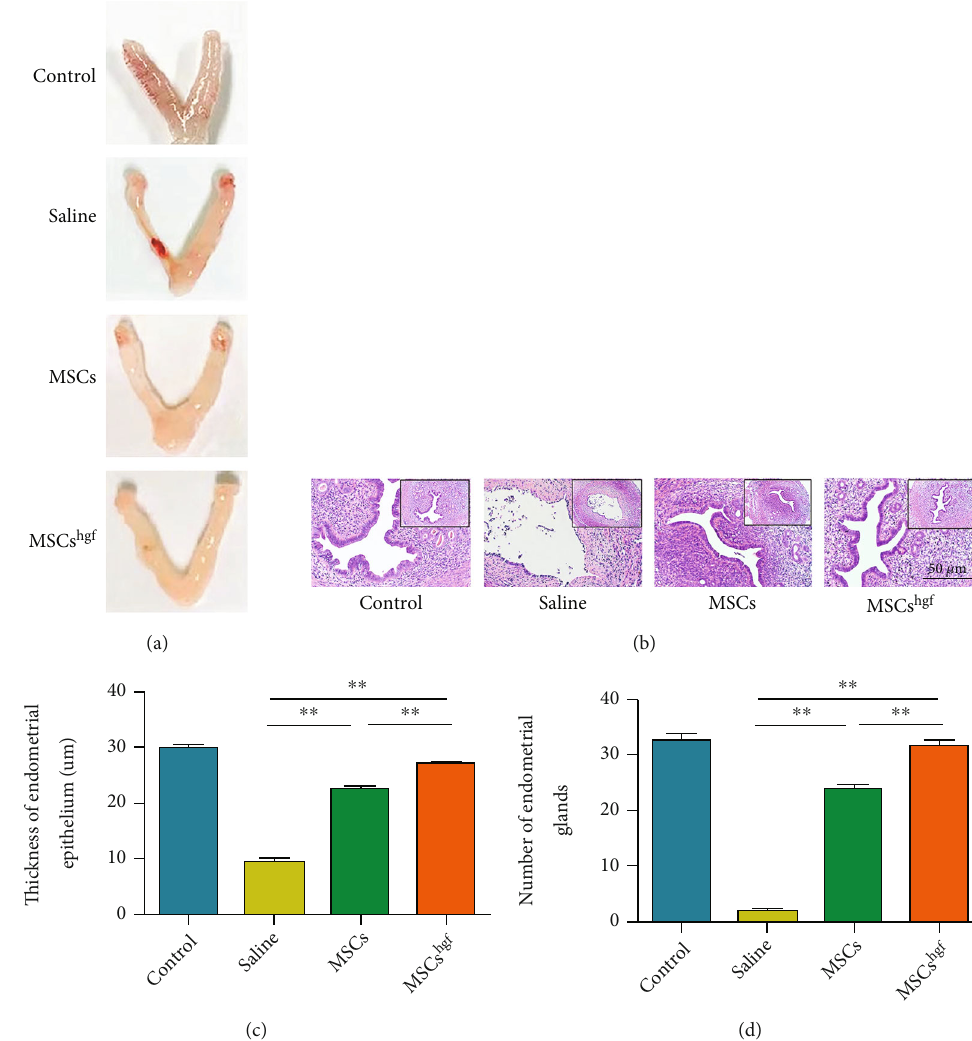
Figure 2: HGF gene-transfected MSCs improve the morphological characteristics and changes of the uterus. (a) Morphological comparison of mouse uterine specimens in each treatment group. (b) H&E staining of mouse uteri in each treatment group (40x). (c) Di ff erence of the thickness of endometrial epithelium in each treatment group ( ∗∗ P < 0 : 01 , n = 10 ). (d) Di ff erence of the number of glands in each treatment group ( ∗∗ P < 0 : 01 , n = 10